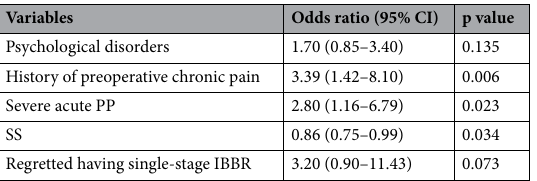
Table 4. The multivariate analysis of risk factors for CPSP. PP postoperative pain, IBBR implant-based breast reconstruction, SS satisfaction score.